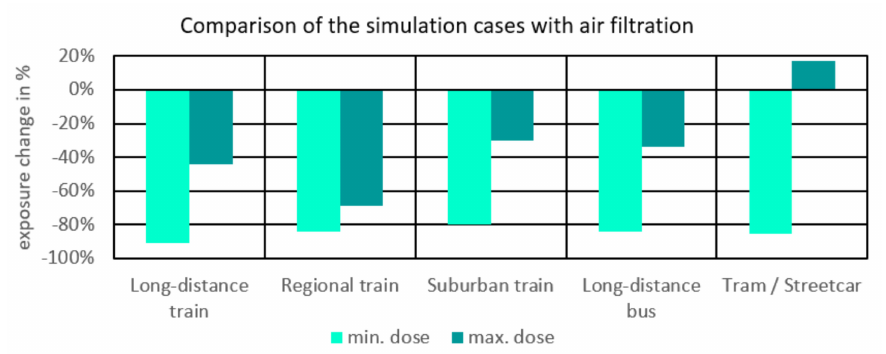
Figure 11. Influence of filtering on the amount of exposure: min. dose, minimum dose absorbed farther away from the emitter; max. dose, maximum exposure that is absorbed close to the